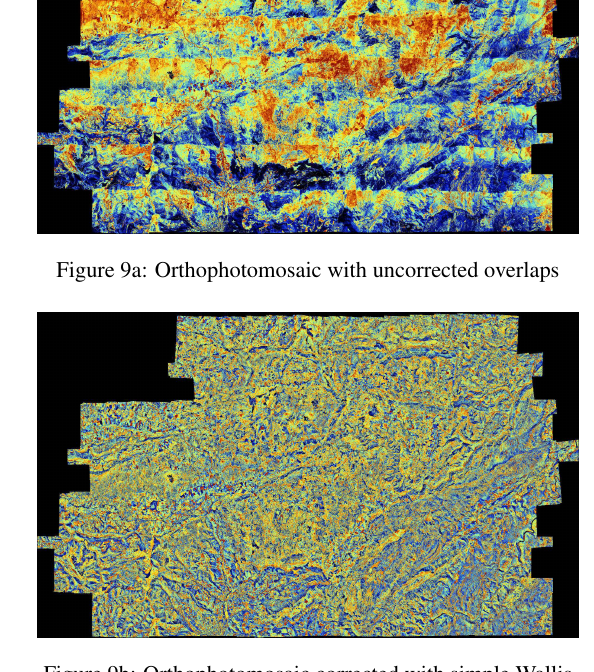
Figure 9b: Orthophotomosaic corrected with simple Wallis